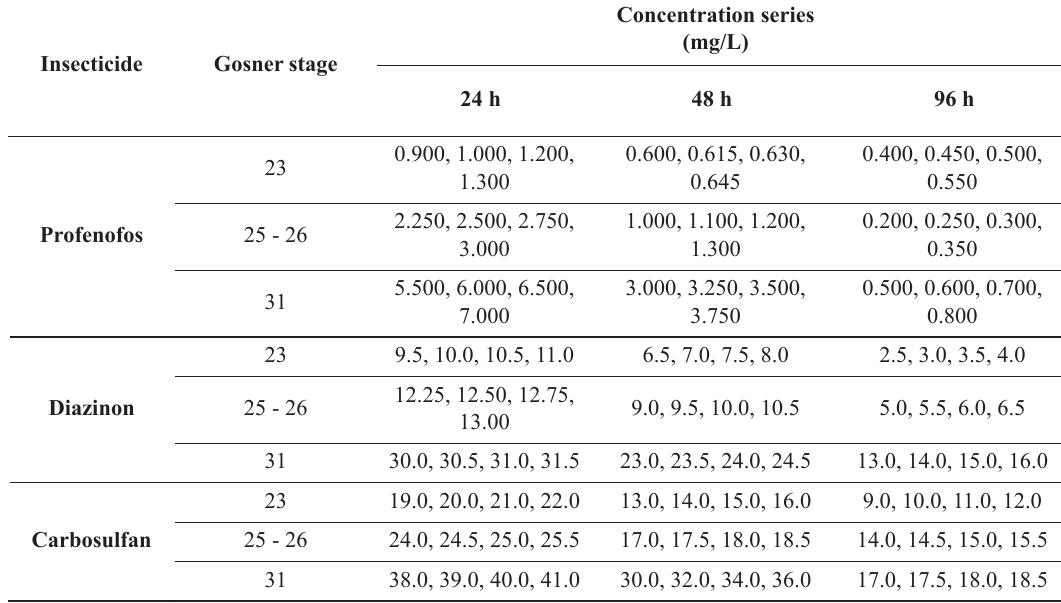
Table 1: Concentration series of insecticides used to determine at 24 h, 48 h and 96 h LC Polypedates cruciger ( n = 2,160